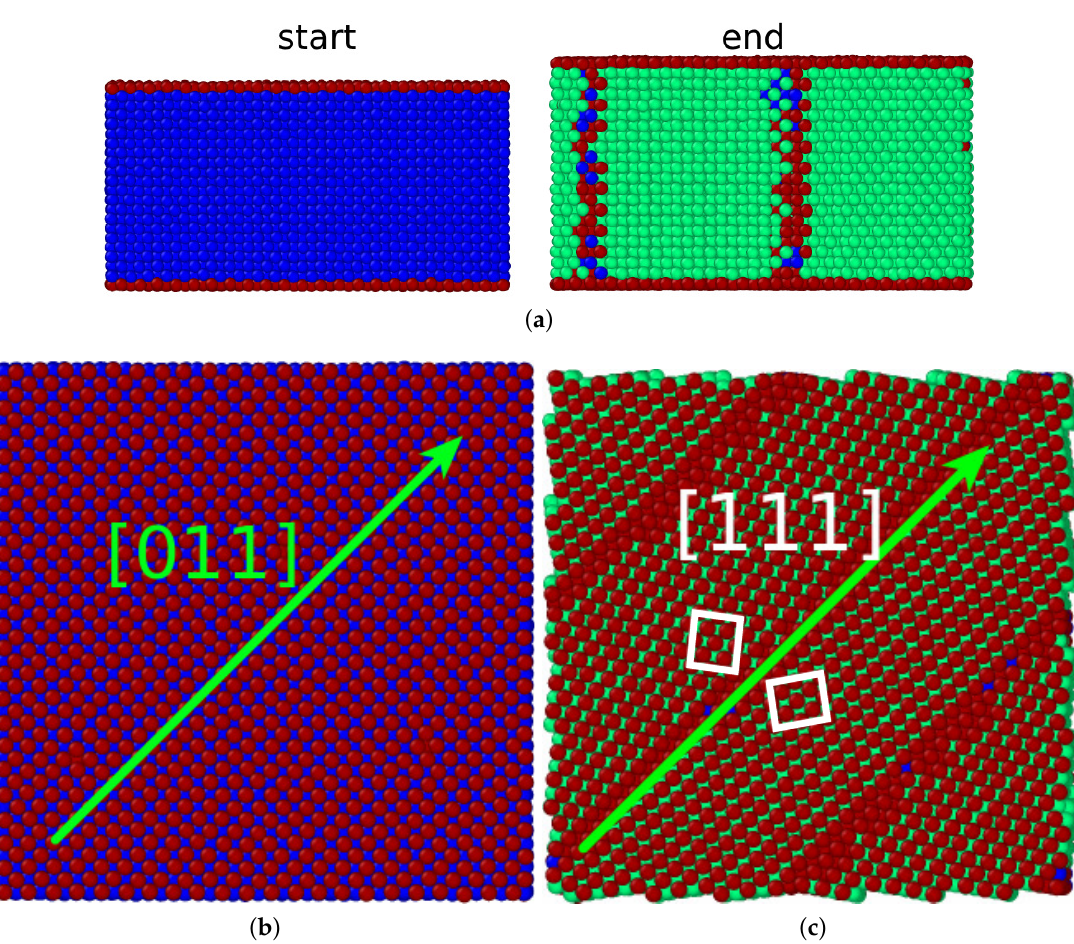
Figure 7. Martensitic transformation of a thin-film fcc Fe slab with a (100) surface: ( a ) side views of the film before and after the transformation; ( b ) top views of the film before the transformation; and ( c ) top views of the film after the transformation. The green arrows indicate the conserved directions, while the white rectangles highlight the twin structure. Colors denote local lattice structure as in Figure